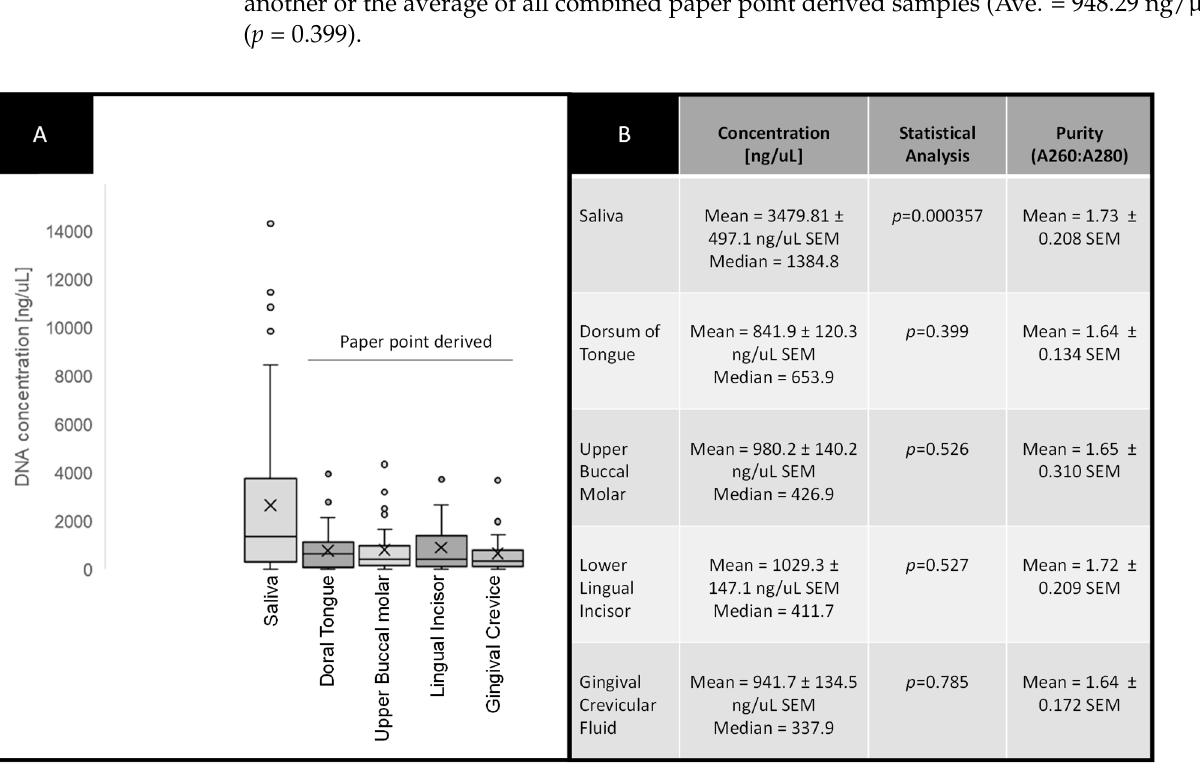
5 Table 1. Study sample demographics. Study Sample